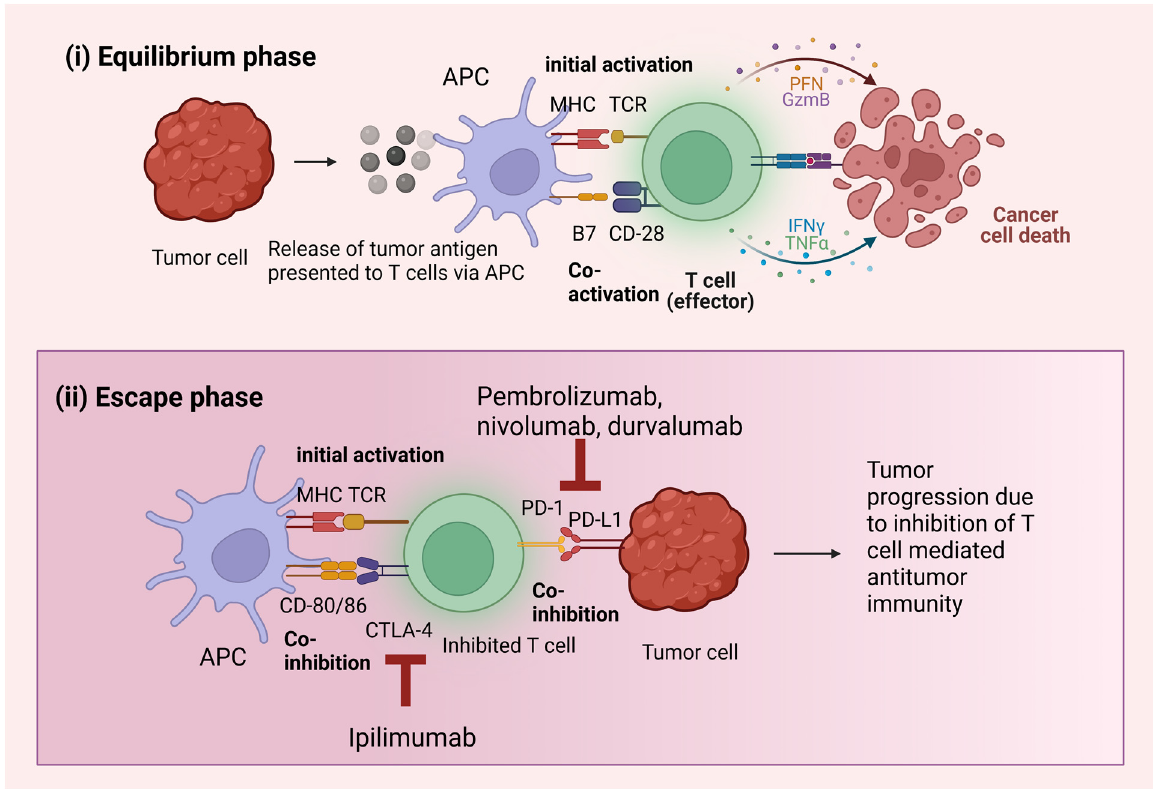
Figure 1. Tumor behavior in the presence and absence of ICIs. ( i ) Tumor cells in the equilibrium phase do not survive due to the presence of initial as well as co-activation markers. ( ii ) Tumor pro- gresses due to the absence of co-activation. Initial activation is present along with co-inhibition me- diated by immune checkpoints. The ICIs are antibodies targeting these immune checkpoints,